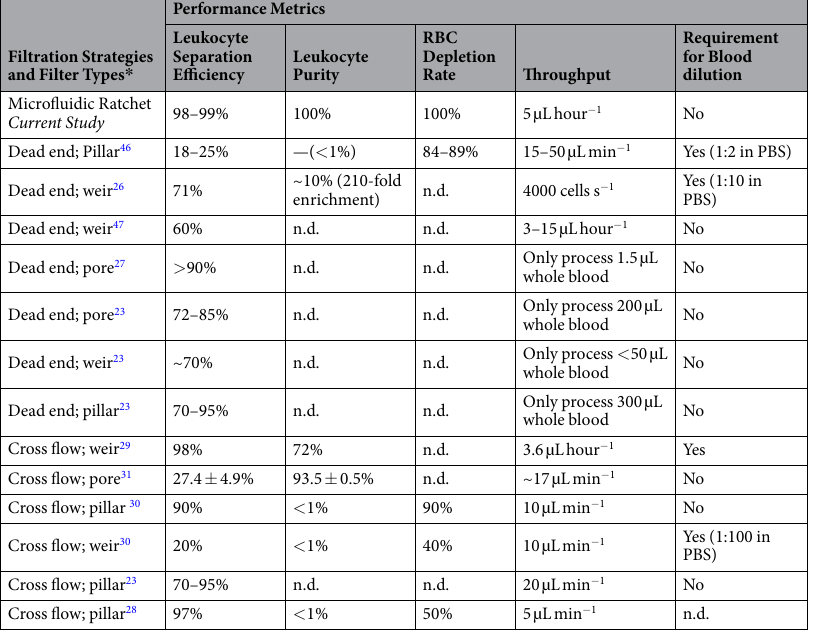
Table 1. Performances of recent research in leukocytes separation from whole blood using microfiltration. n.d. Data not available. * References in